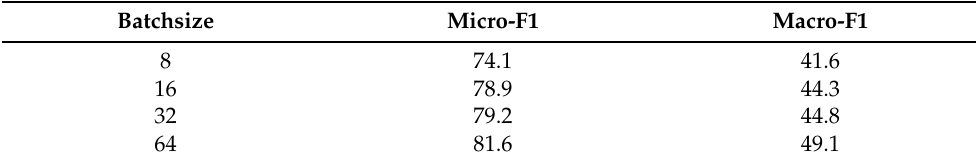
Table 3. Verification experiments on batch size from the MCTest dataset.